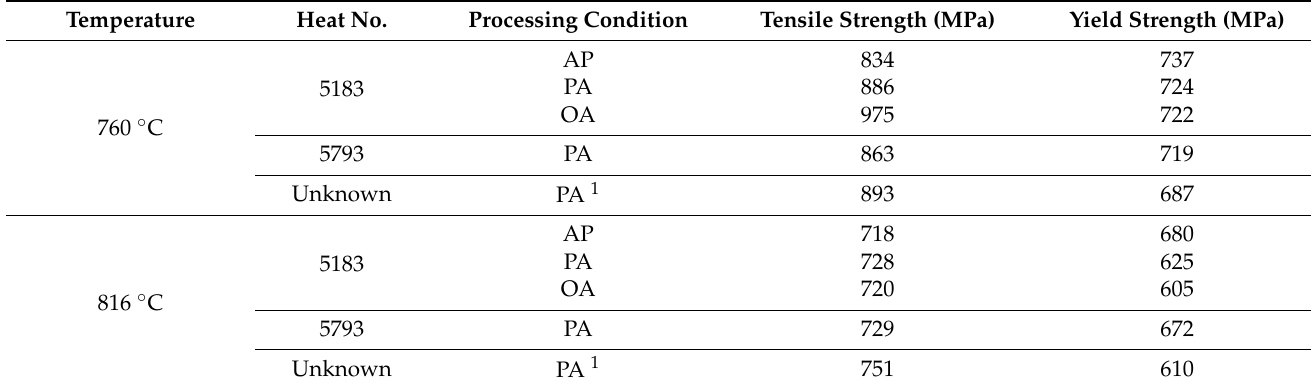
Table A1. Nimonic 105 tensile strength values